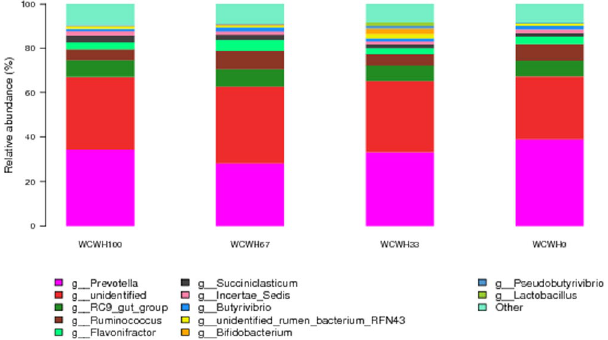
Figure 4. The effects of dietary treatments on the relative abundance of genera in the ruminal bacterial